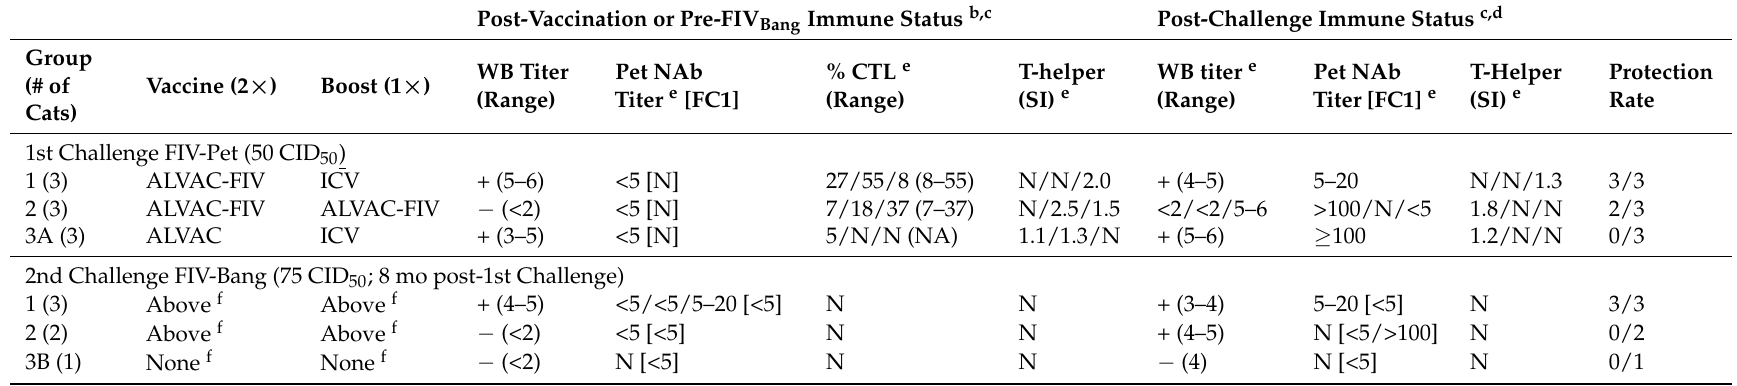
a Table 5 adapted and summarized from [56]. b Immune status of post-vaccination before 1st challenge (FIV (FIV